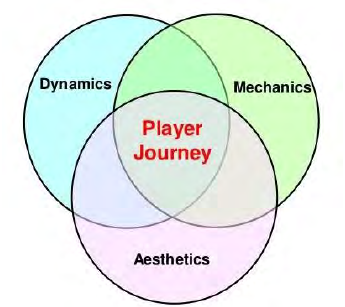
Figure 1. The MDA Framework